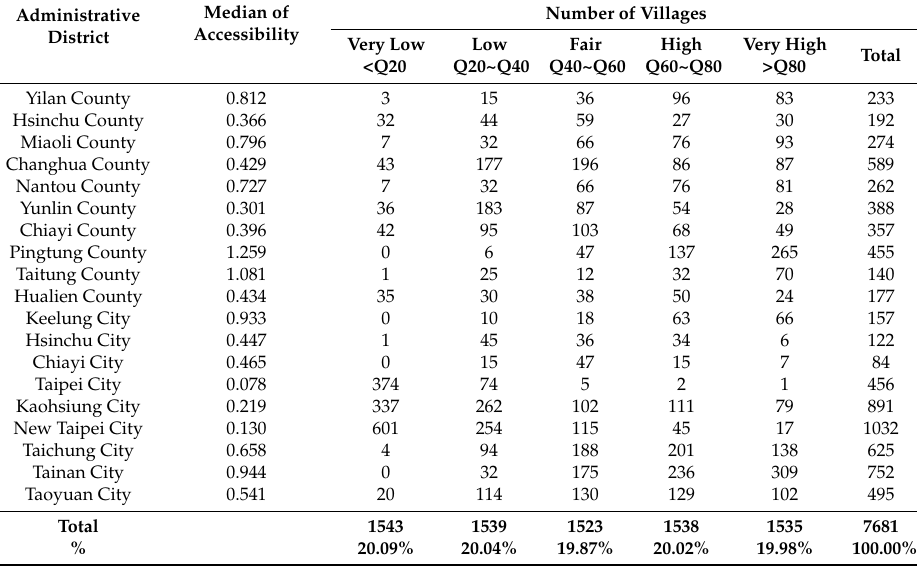
Table 7. Village distribution as estimated by scores of accessibility based on method M6 (estimated by